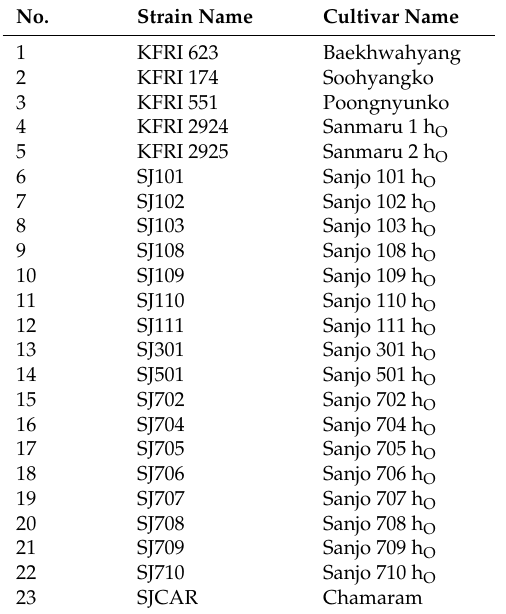
Table 1. List of shiitake mushroom ( Lentinula edodes )